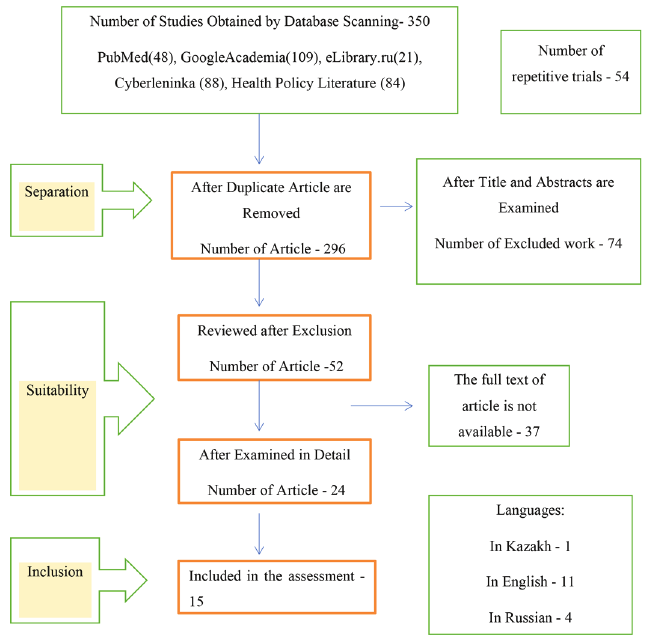
Figure 1 - Algorithm for selecting scientific